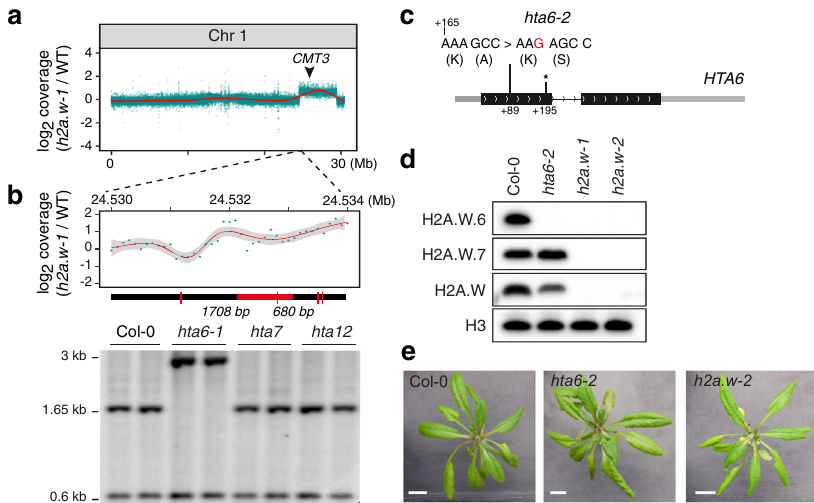
Fig. 1 H2A.W is not required for Arabidopsis development. a Sequencing coverage of published h2a.w-1 BS-seq data 22 , averaged in 1kb bins across chromosome 1. The red line shows the smoothed conditional mean (LOESS). The black arrowhead indicates the genomic location of CMT3 . See also Supplementary Fig. 1a. b Zoomed-in view of plot in a across the left border of the chromosome 1 region showing increased coverage in h2a.w-1 (top panel). DNA gel blot analysis of the chromosome 1 region showing abnormal coverage in h2a.w-1 in the indicated T-DNA insertion mutants (lower panel). Genomic DNA of the indicated genotypes was digested with Ssp I (recognition sites indicated by red ticks on the thick black line) and hybridized with a fragment corresponding to the genomic region indicated in red under the plot. Two independent experiments were performed with identical results. c The hta6-2 CRISPR-Cas9 mutant allele. Diagram of the HTA6 gene showing the insertion of a G (in red) in hta6-2 , which creates a frame shift 89bp downstream from the translation initiation site and an early stop codon (asterisk) 195bp downstream from the translation initiation site. d Western blot showing total loss of H2A.W in h2a.w-1 and h2a.w-2 . Nuclear extracts of the indicated genotypes were analyzed using antibodies directed against H2A.W.6, H2A.W.7, total H2A. W, and H3. Two independent experiments were performed with similar results. e Representative images of wild-type, hta6-2 , and h2a.w-2 plants (scale bar = 1 cm). Both hta6-2 and h2a.w-2 mutants develop like wild-type Col-0 plants. Source data underlying Fig. 1b, d are provided as a Source Data fi